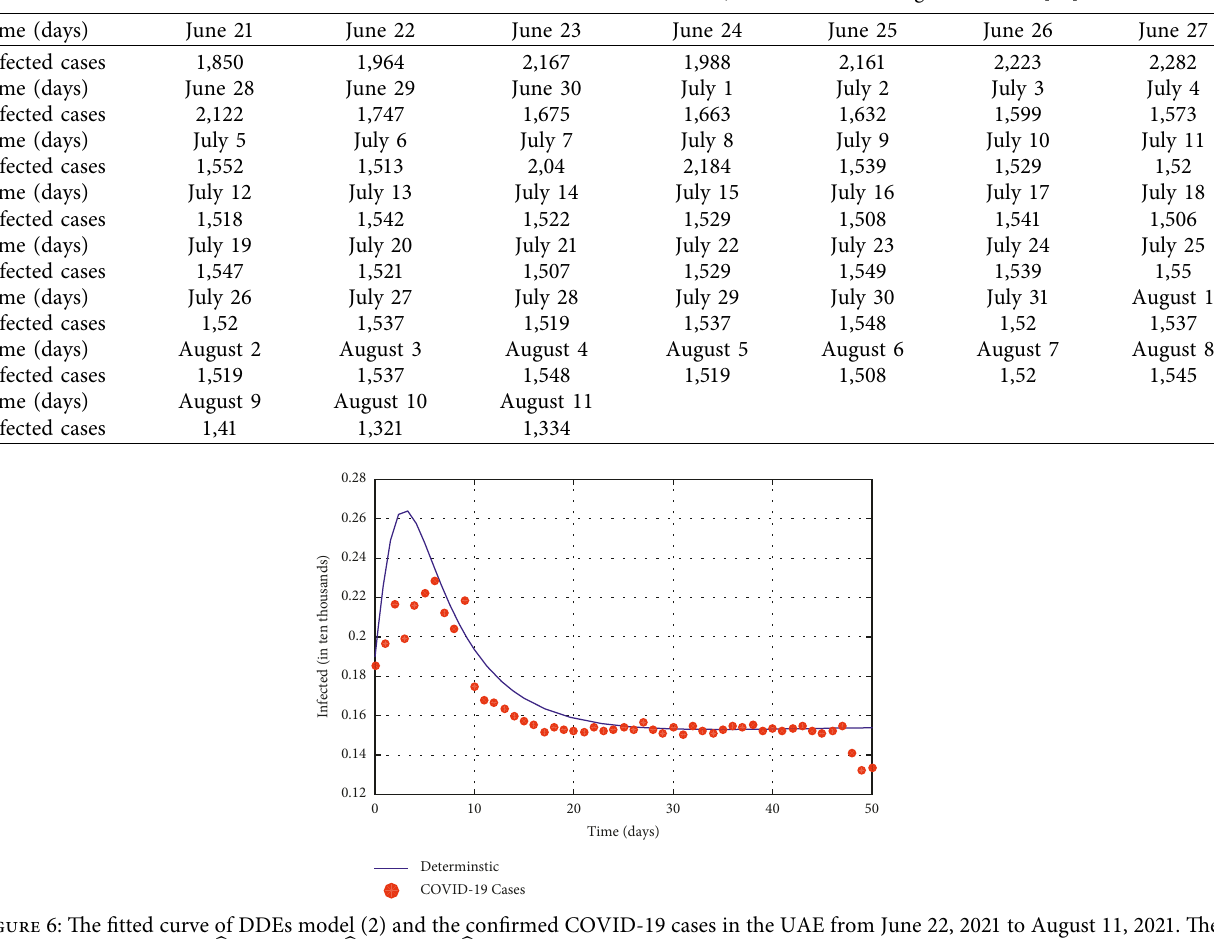
Table 1: Number of recorded COVID-19 cases in the UAE, from June 21, 2021, to August 11, 2021 [36].